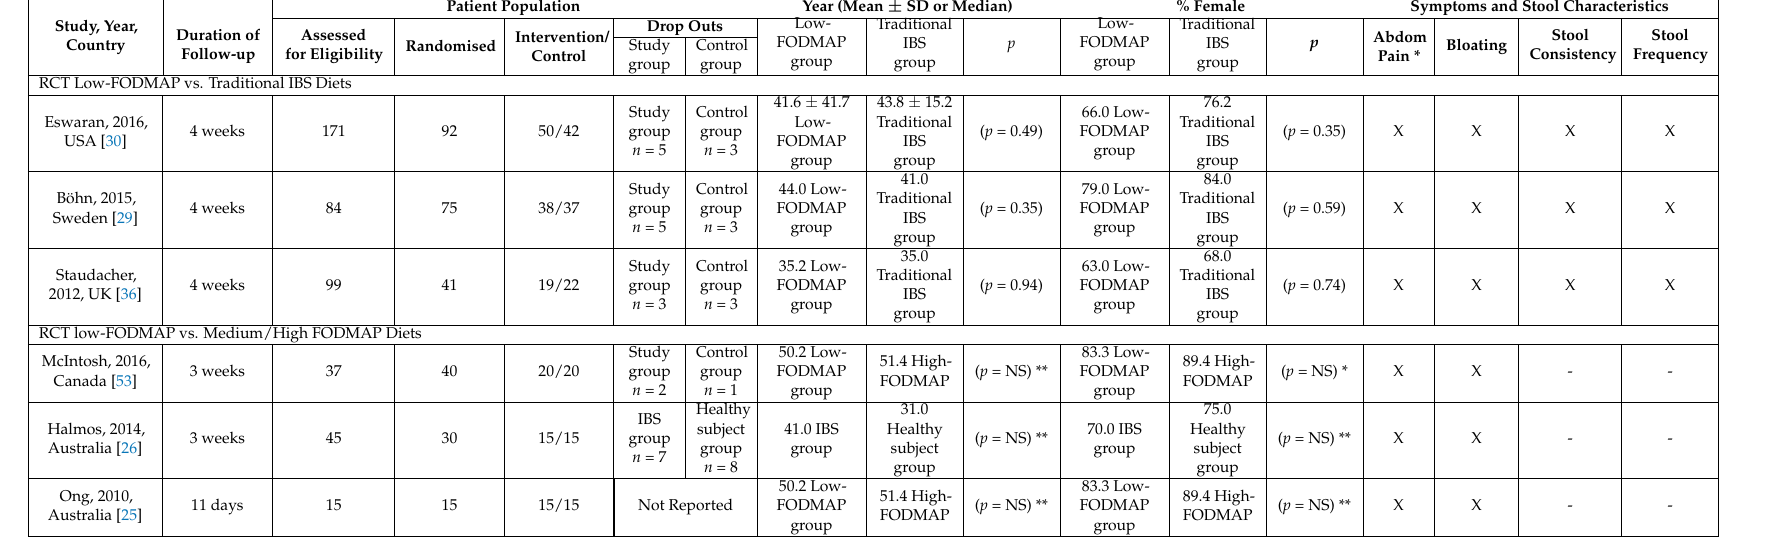
Table 1. Characteristics of the included randomised control trial (RCT) studies in the meta-analysis.